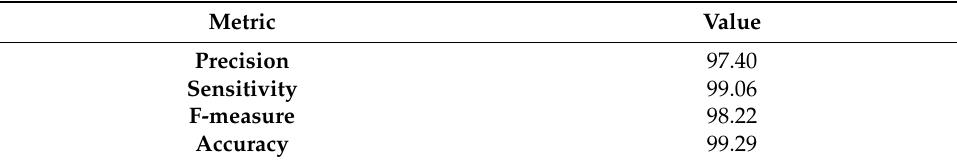
Table 6. Optimised Random Forest results on the 380,000 mixed records